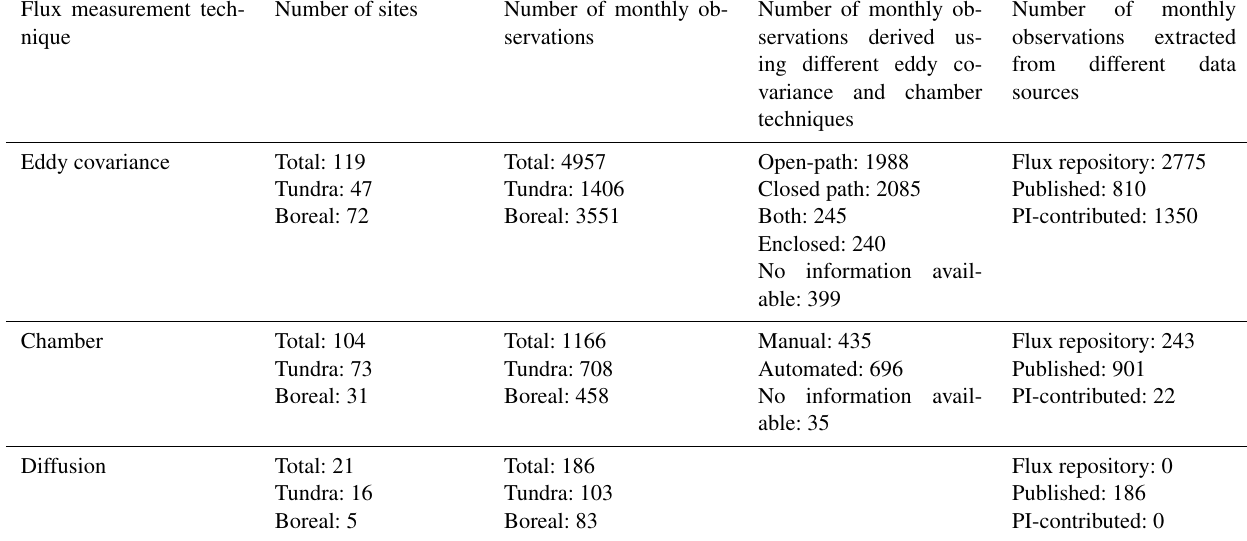
Table 3. General statistics of the database. Number of monthly CO 2 flux measurements and sites derived from eddy covariance, chamber, and diffusion techniques, and the proportion of data coming from different data sources. Note that some of the data extracted from flux repositories and papers were further edited by the PIs; this information can be found in the database. For this table, observations that were fully contributed by the PI were considered as PI-contributed.